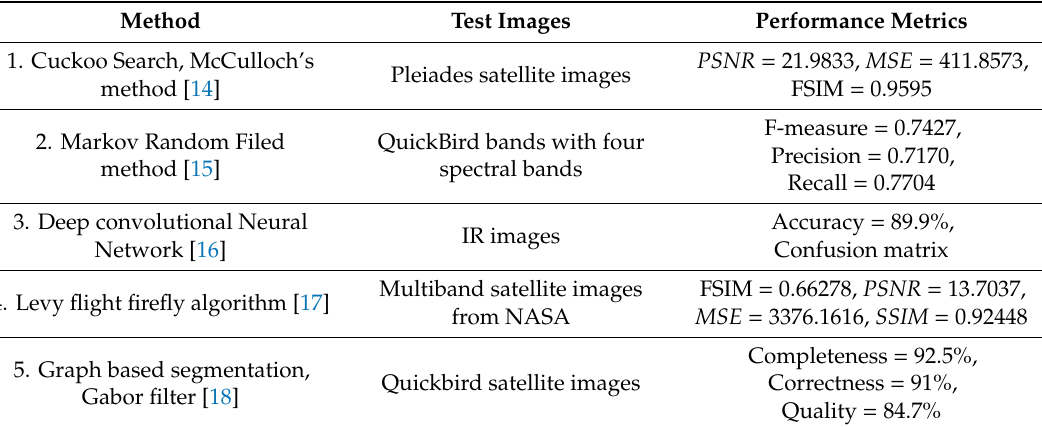
Table 3. Image segmentation methods and their performance